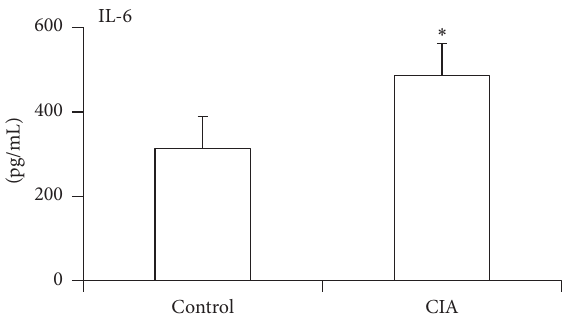
Figure 3: Increased IL-6 expression in rat collagen-induced arthritis. Blood samples were collected from the intraocular adjoined veins of the rats on day 17 after initial immunization from CIA rats and control rats. IL-6 in sera was determined by ELISA kit. The data are presented as mean ± SD ( 𝑛 = 6 – 8 /group) and are representative of three independent experiments. ∗ 𝑝 < 0.05 .